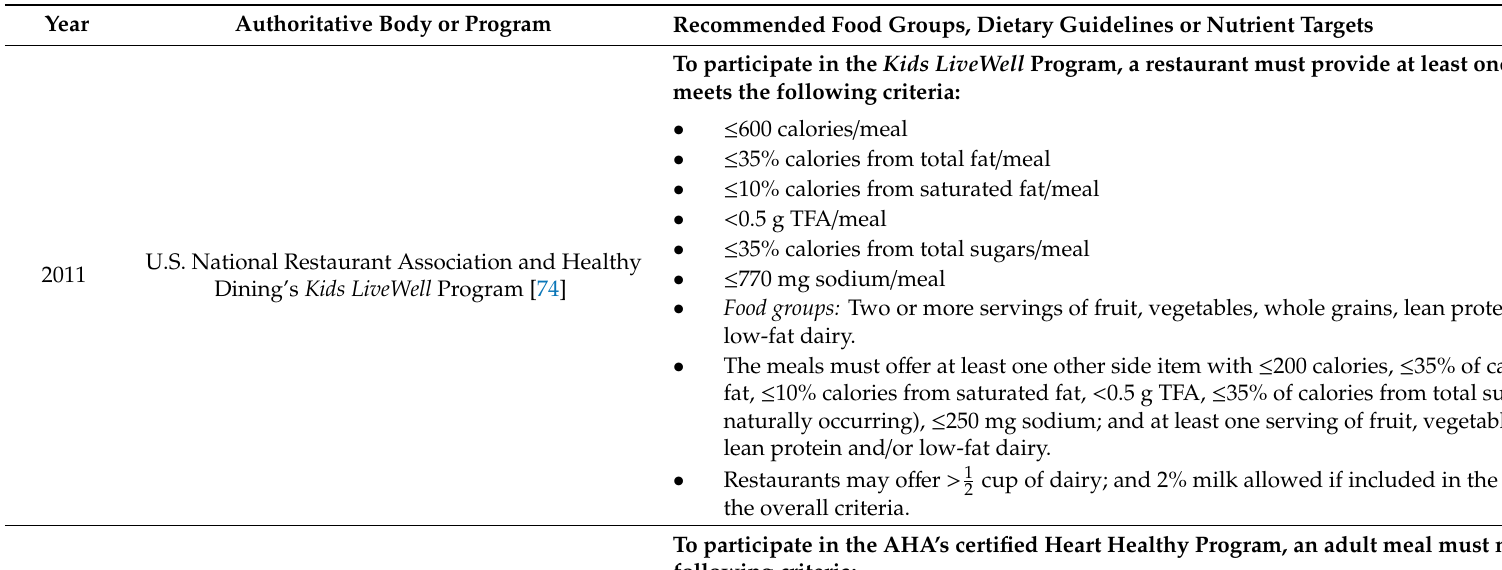
Table 3. Recommended dietary guidelines for restaurant chains to reformulate and standardize serving sizes of products to meet healthy dietary guidelines